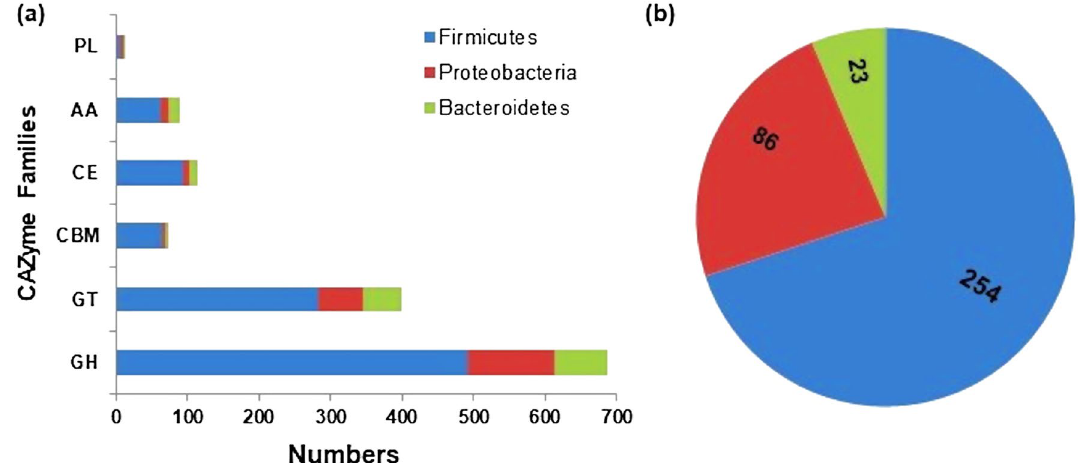
Figure 7. Phylogenetic distribution of CAZymes in RSV consortium. ( a ) Relative abundance of total CAZymes of GHs, GTs, CBMs, CEs and AAs families in various phyla and ( b ) Distribution of functionally assigned lignocellulolytic GHs, CEs and AAs in various